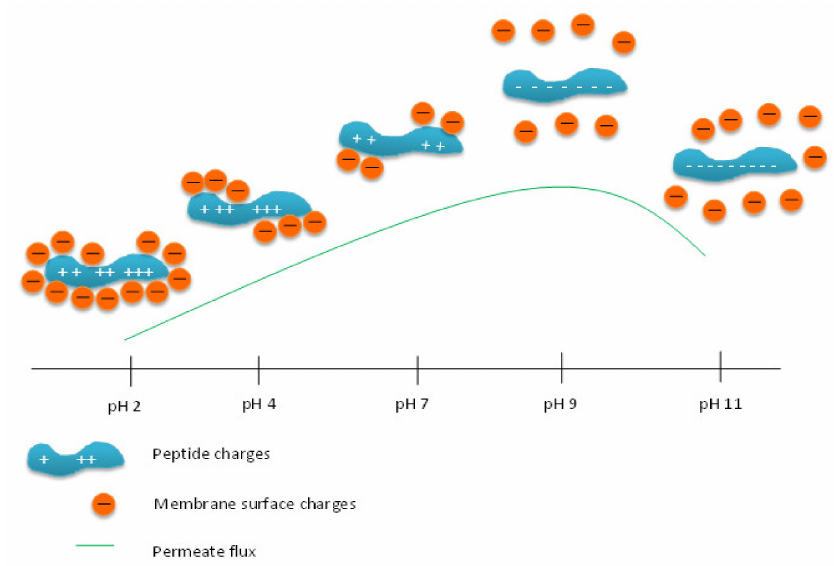
Figure 8. Schematic drawing of peptide structure and membrane surface state for single